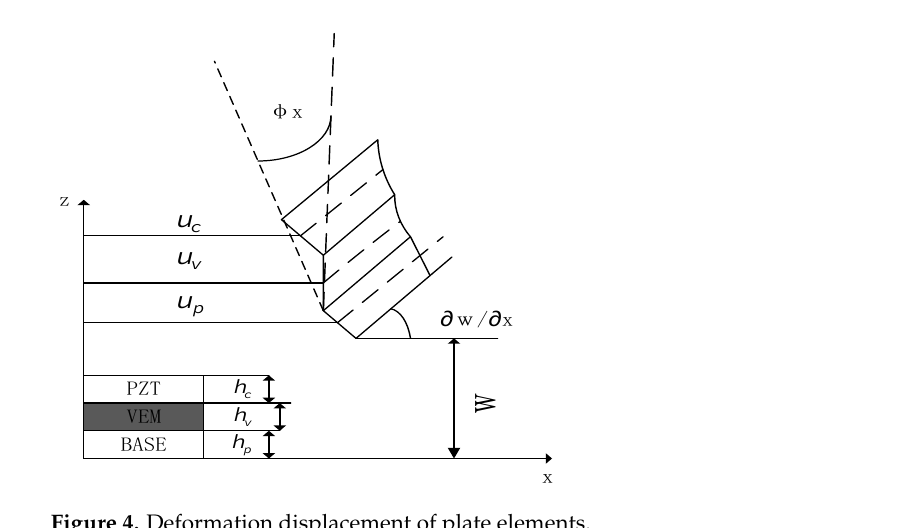
Figure 4. Deformation displacement of plate elements.